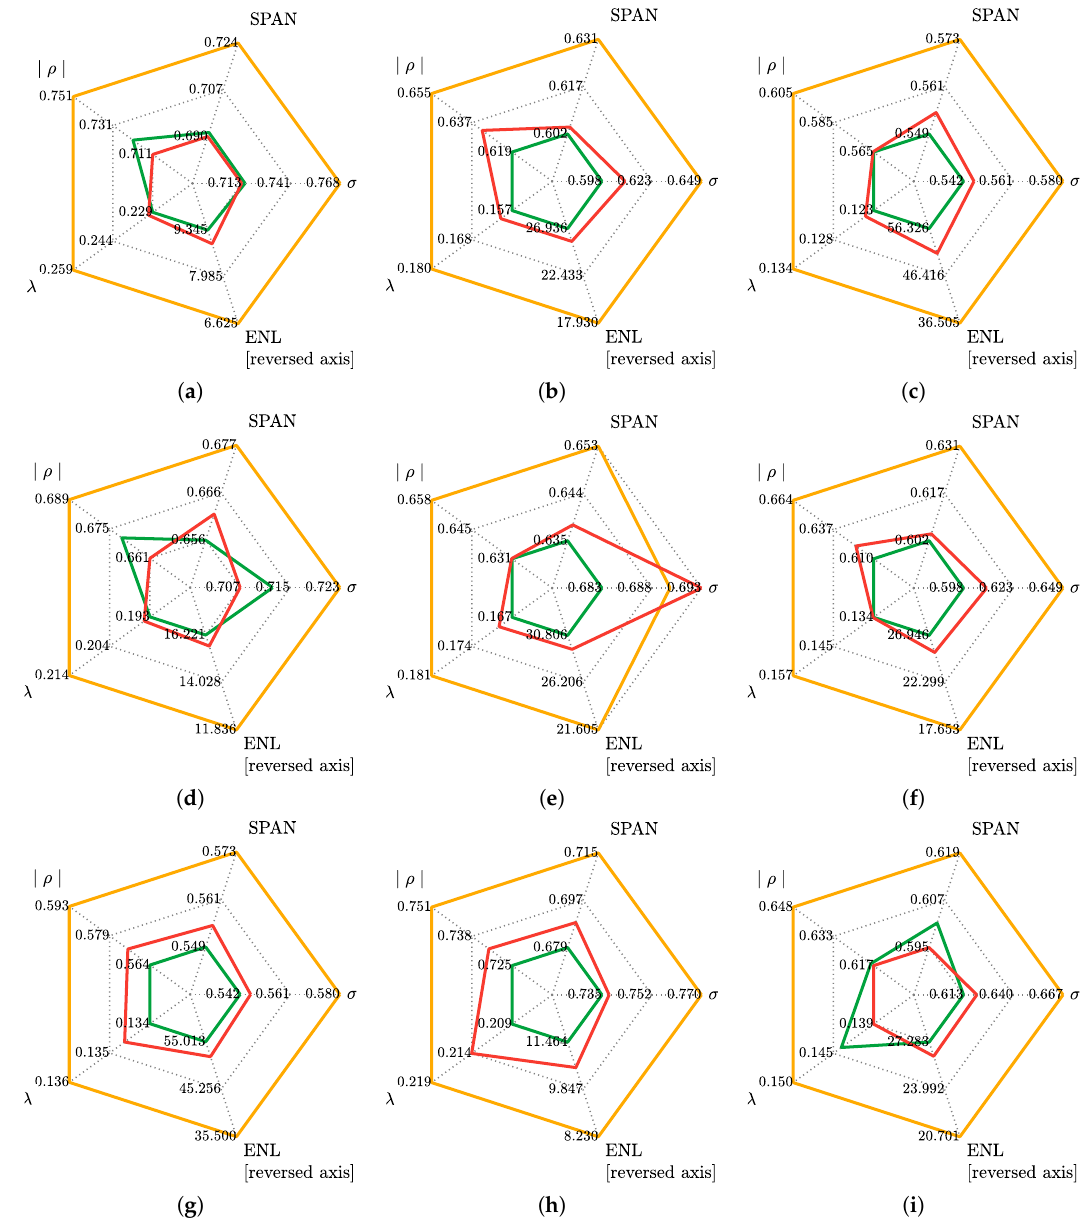
Figure 7. Spider plots of the despeckling performances for uncorrelated (green), correlated (yellow), and decorrelated (red) speckles: ( a ) boxcar 3 Lee 5 5, ( e ) refined Lee 7 × ( i ) intensity-driven adaptive-neighborhood